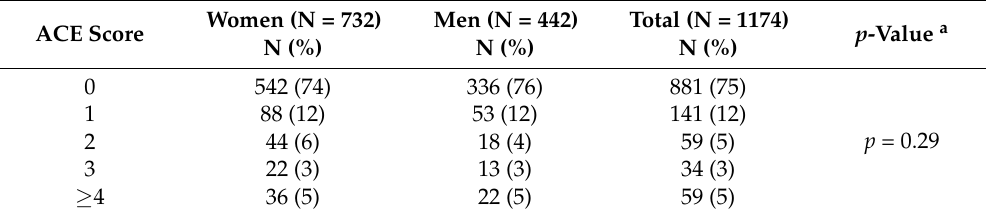
Table 2. Distribution of ACE Score overall and by